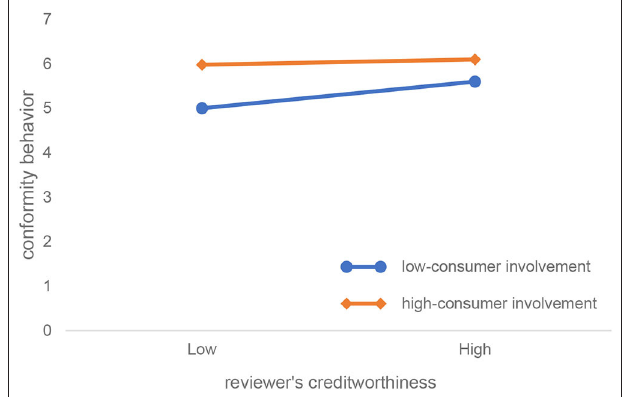
FIGURE 5 | The effect of consumer involvement on reviewer’s creditworthiness and conformity